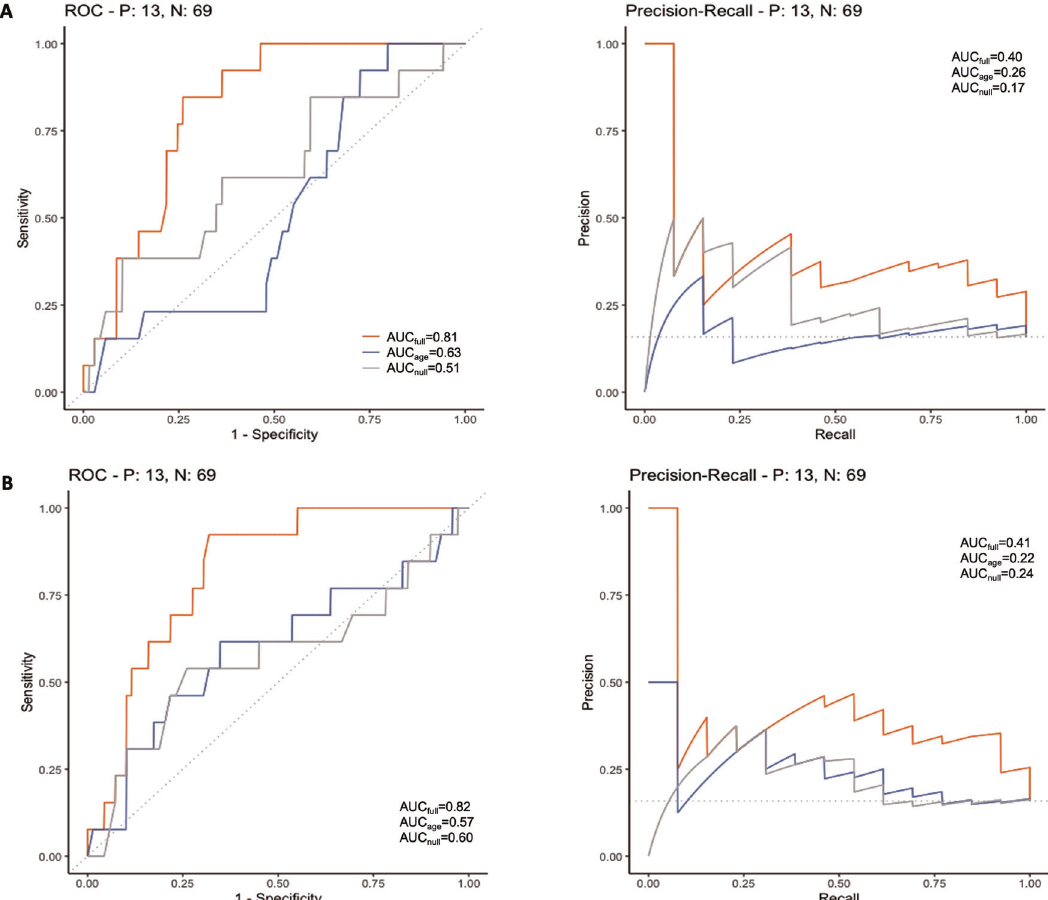
Fig. 2 ROC and PR curves of the prediction model comparisons. ROC and PR curves of the prediction model comparisons (between full, age- only and null models) using biomarkers collected during the 2nd trimester to predict 3rd trimester EPDS ≥ 13. A using ordinal regression (cumulative probability that EPDS ≥ 13), B logistic regression (estimated probability EPDS ≥ 13). The full model outperforms the other two models in both the ROC and PR curves. The performance of the PR curve is important when the number of cases (EPDS ≥ 13) is not equal